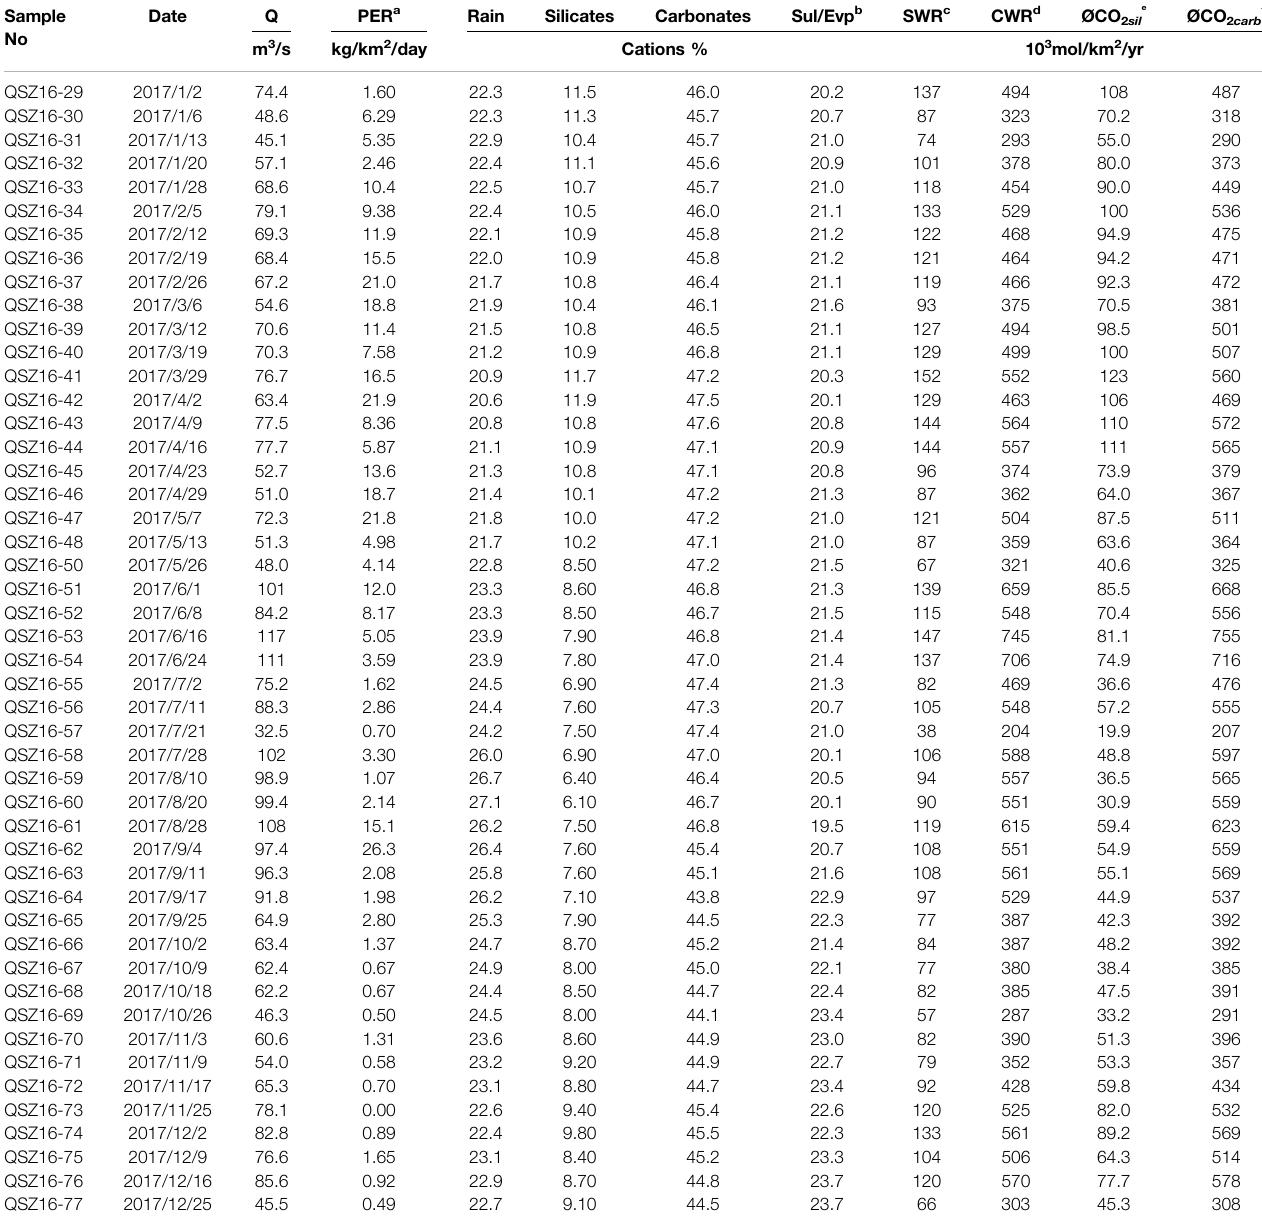
TABLE 3 | Chemical weathering fl uxes and CO 2 consumption rates for the Datong River catchment. Sample